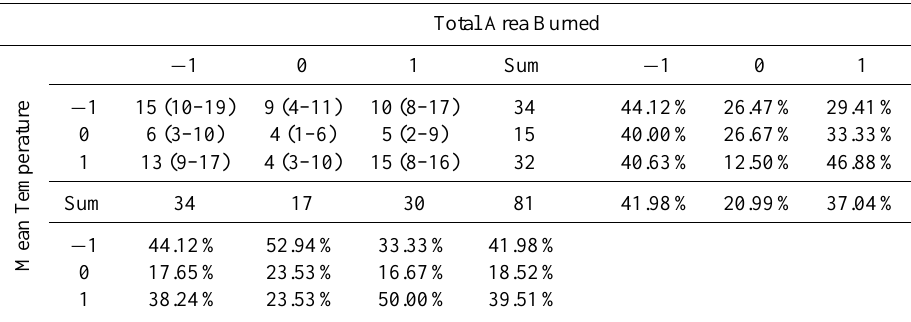
Table 3. Cross-tabulation results between area burned area and mean air temperature. The Monte Carlo randomization confidence limits are in parentheses.